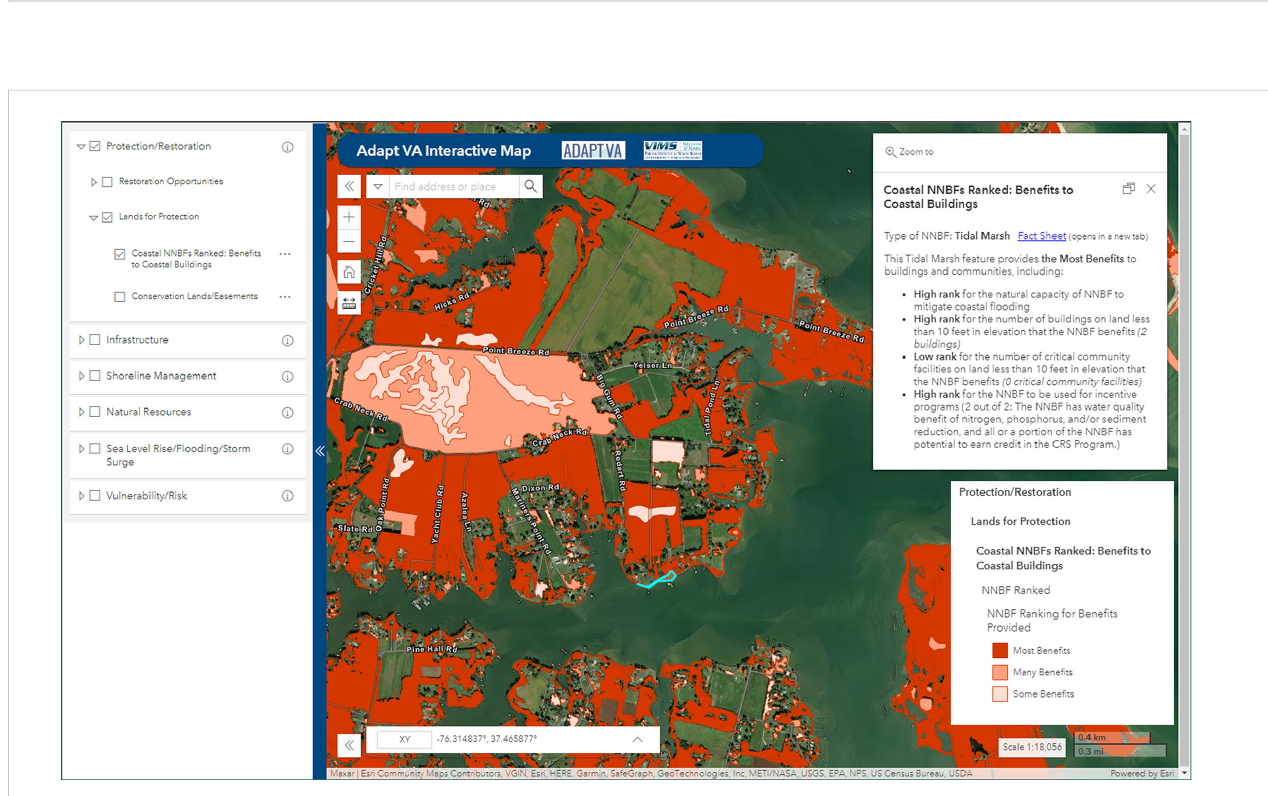
FIGURE 9 Project outputs are served on the interactive mapping tool located at AdaptVA 1 . This screenshot shows target areas, the layer located under Restoration Opportunities , with its informational popup designed to guide decisions on potential NNBF suitable for that